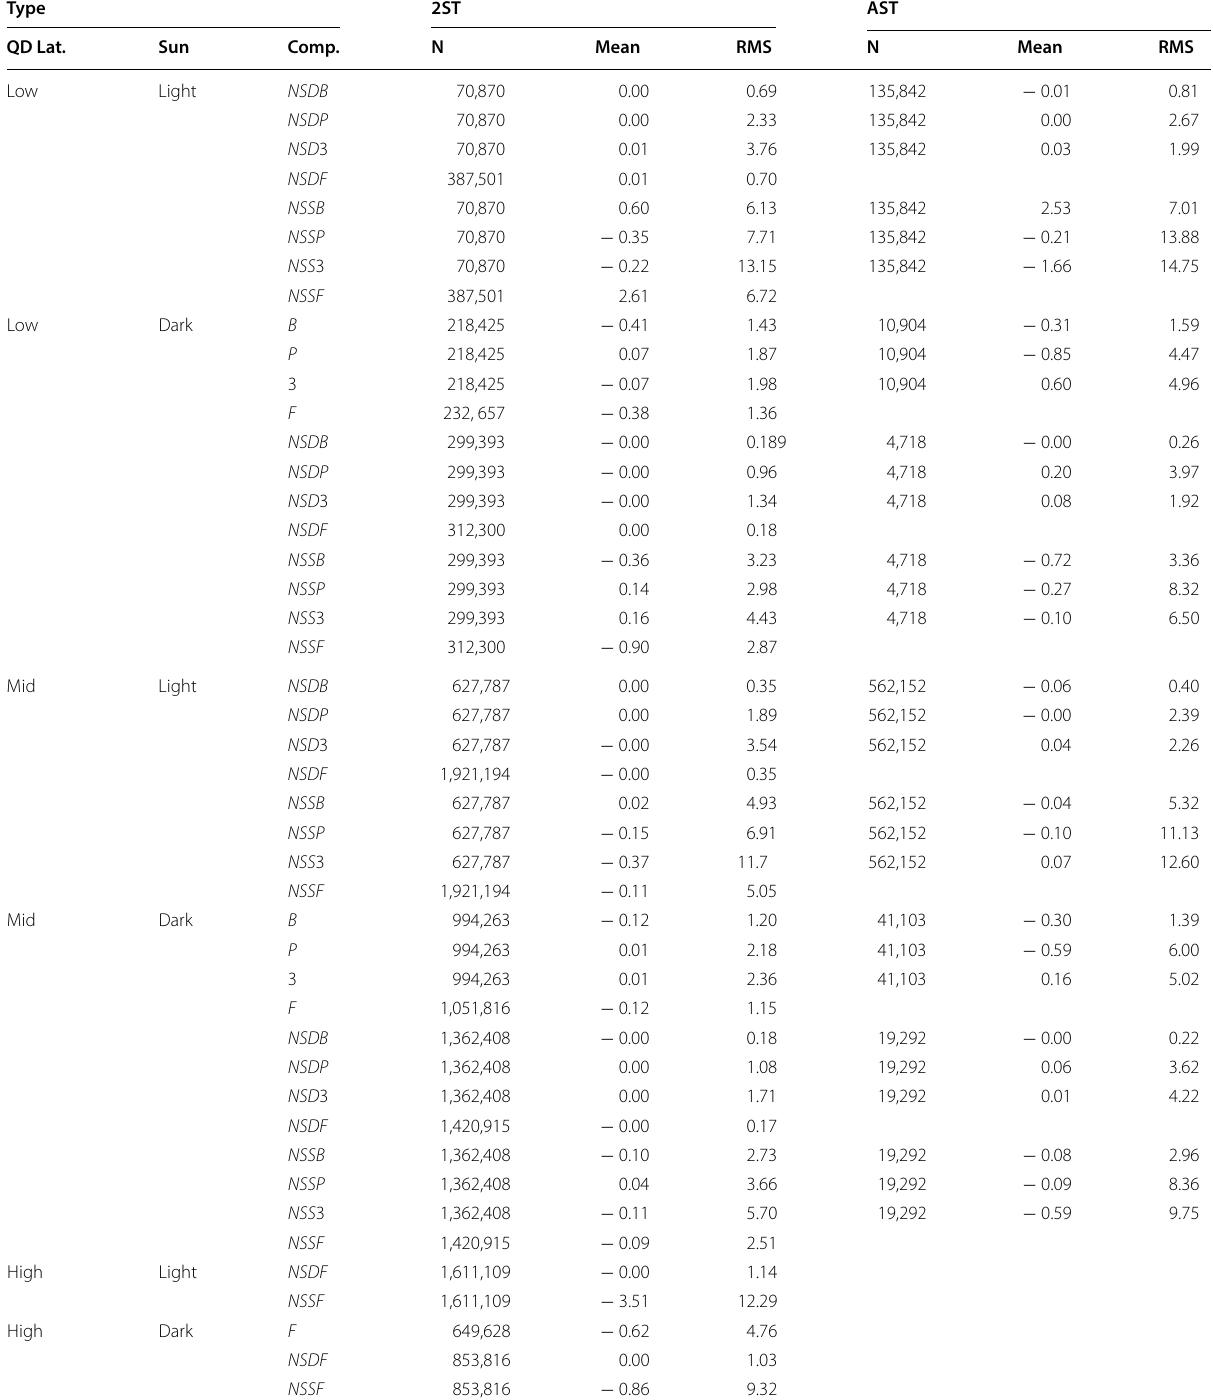
Table 5 CM6 weighted residual statistics for CHAMP 2ST and AST, where “QD” denotes Quasi-Dipole, “ NS ” denotes North–South along-track, “ DF / SF ” denotes scalar differences and sums, respectively, “ DB / SB ”, “ DP / SP ”, and “ D 3/ S 3” denote vector differences and sums in the HB-theory frame, respectively, “ F ” denotes scalar, and “ B ”, “ P ”, and “3” denote vector measurements in the HB-theory frame,